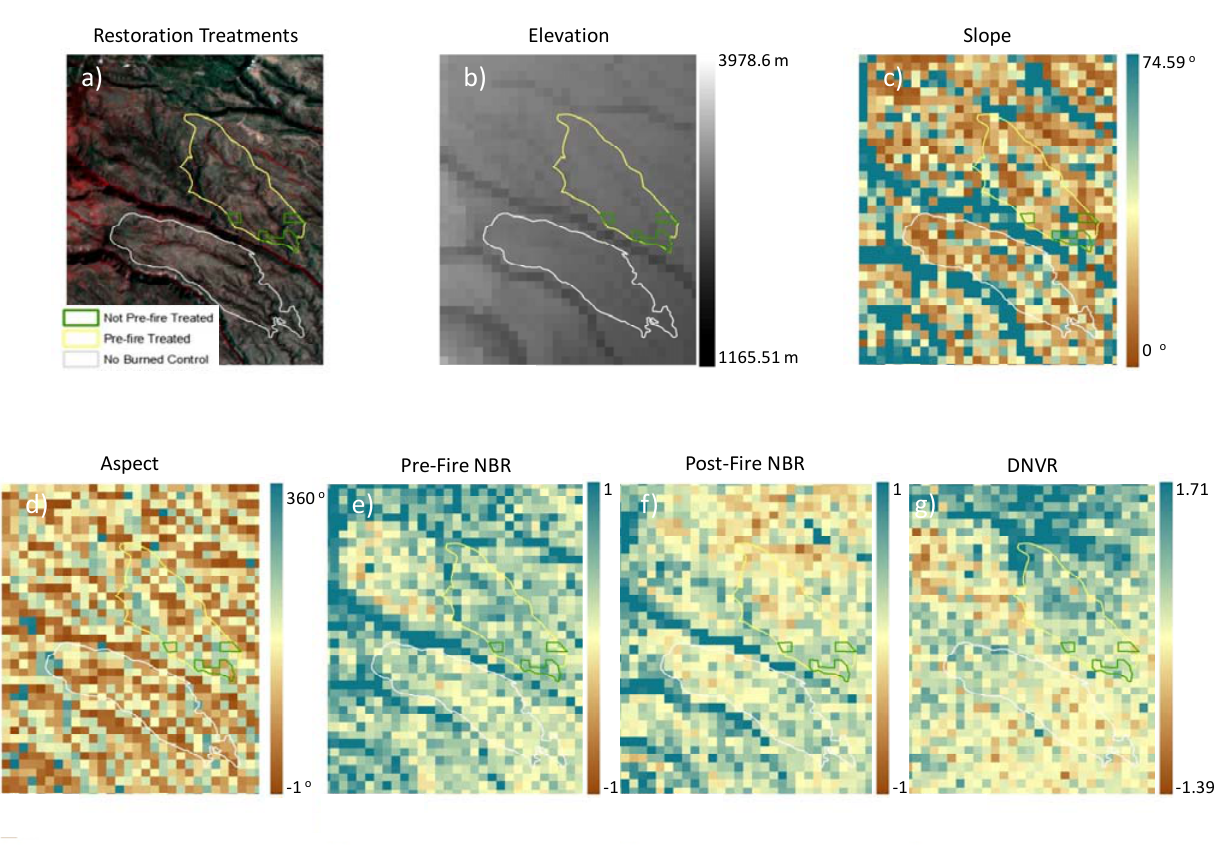
Figure 5. Explanatory variables used by Multiple Linear Regression (MLR) and Classification and Regression Tree (CART) models. ( a ) An example of the qualitative variable for pre-fire treatments (only used in CART) ( b – d ) Variables calculated from the DEM (Slopes, aspect and elevation) ( e – g ) Estimates for fire